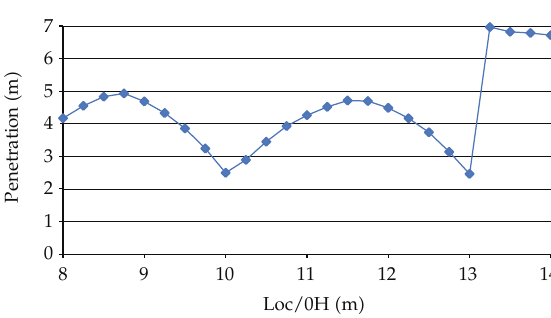
Figure 18: Dry cargo vessel against passenger ship: sensitivity to vertical impact location.